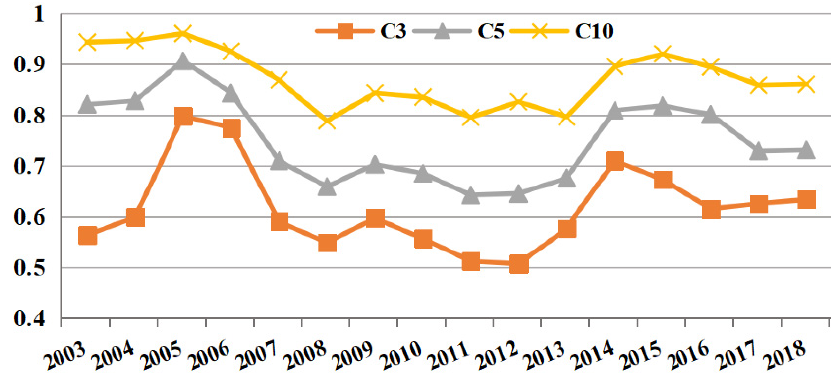
Figure 3. Concentration coefficient of venture capital in China from 2003 to 2018. Combining the trends of the three indicators, it was found that the gini coefficient, location quotient index, and concentration coefficient basically reflected the same trend of Chinese venture capital agglomeration (as shown in Table 2). Based on the three above indicators, we could divide the research period into three periods: (1) from 2003 to 2007, after a short period of rising, the degree of spatial agglomeration of venture capital space began to decline significantly; (2) from 2008 to 2012, the overall degree of spatial agglomeration of venture capital had little change and remained at a low level; (3) from 2013 to 2018, the degree of spatial agglomeration of venture capital gradually increased, and the degree of regional differentiation increased again. It can be seen that the spatial distribution of venture capital projects changed with regional policies, sources of funds, and industrial